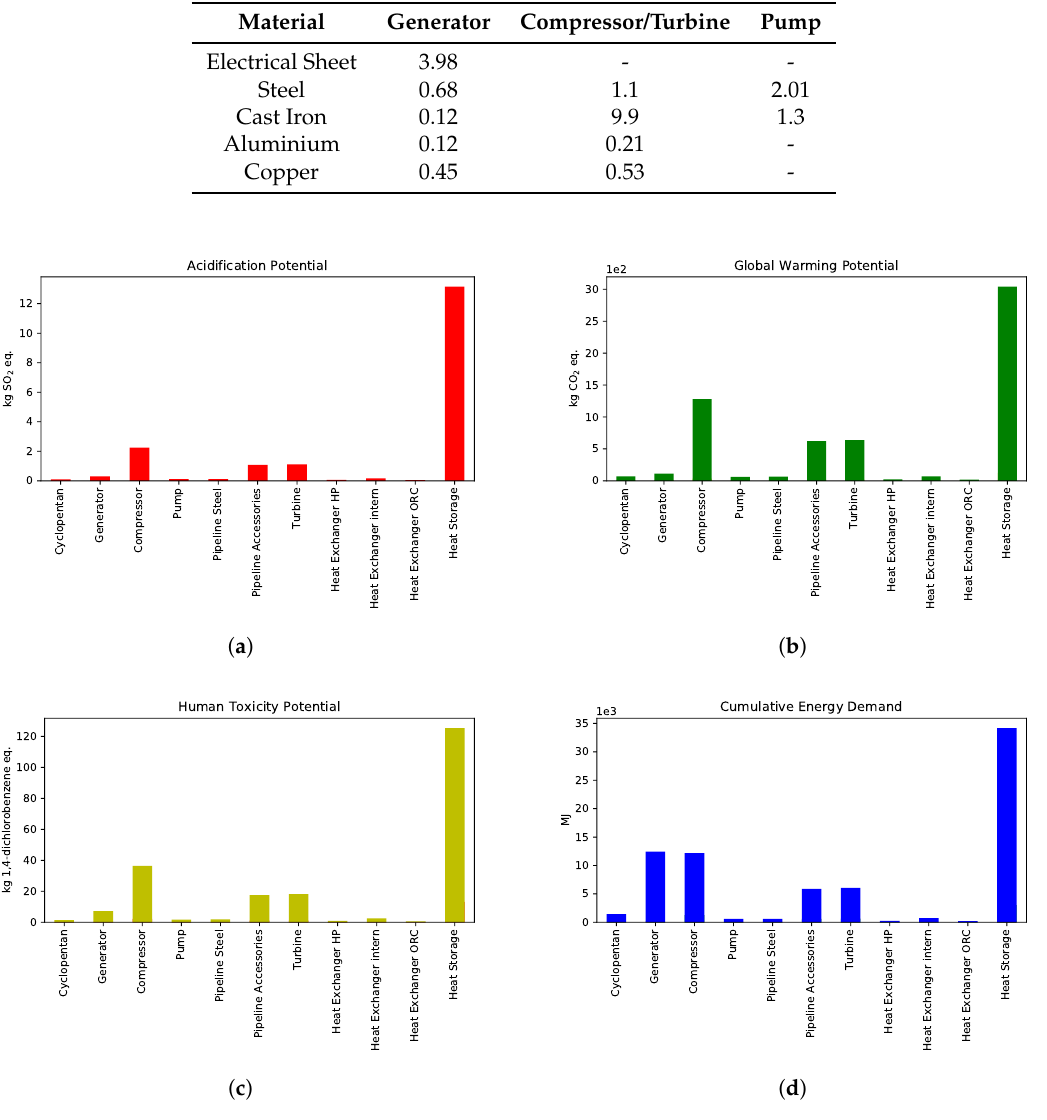
Figure 6. Life Cycle Assessment results of the heat storage system per MWh storage capacity for: ( a ) AP; ( b ) GWP; ( c ) HTP and ( d )